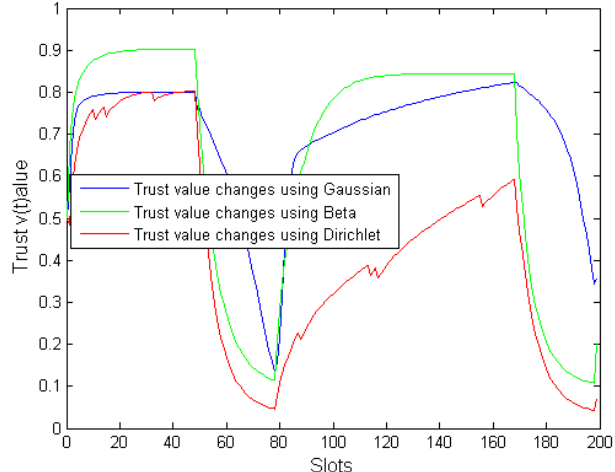
Figure 2. Comparison of trust value between DDTMS, Beta-distribution-based and Gaussian- distribution-based.